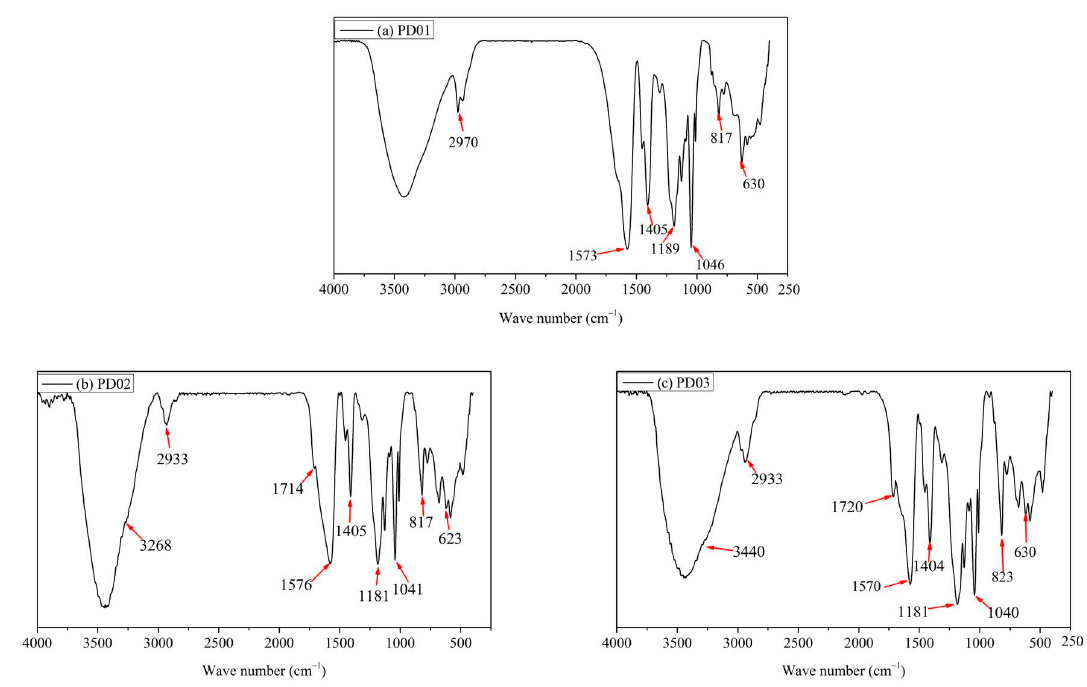
Figure 3. The FTIR spectrum of the dispersants